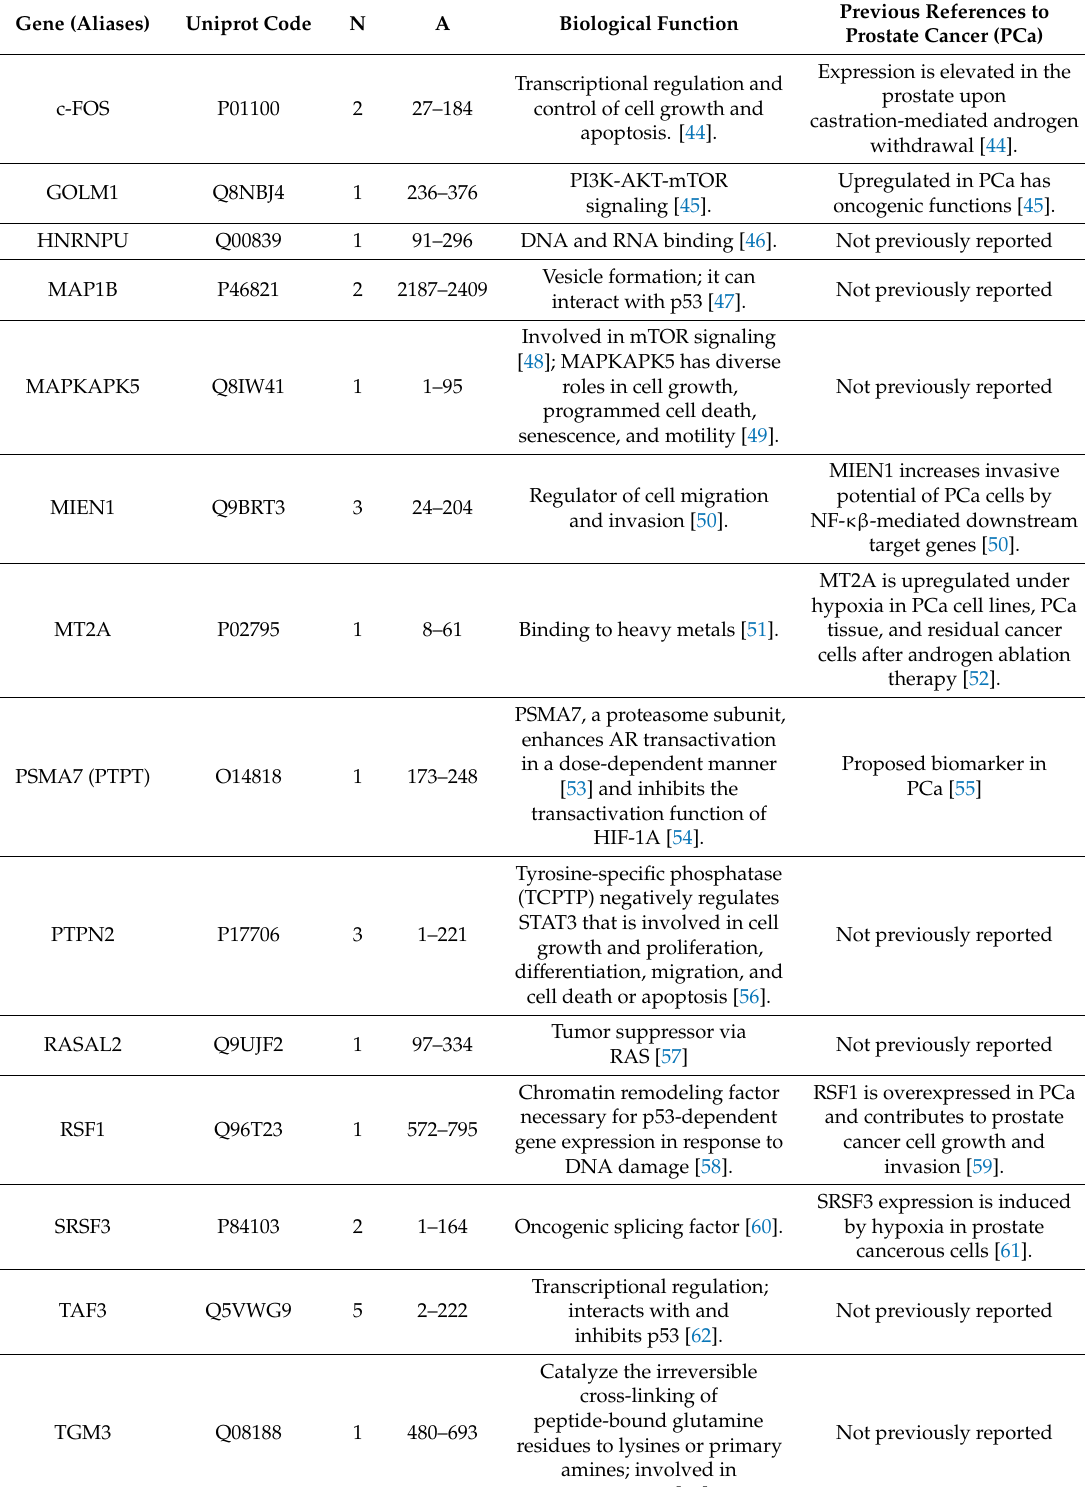
Table 3. Proteins identified in the HMGB1 Y2H interactome in primary tumor